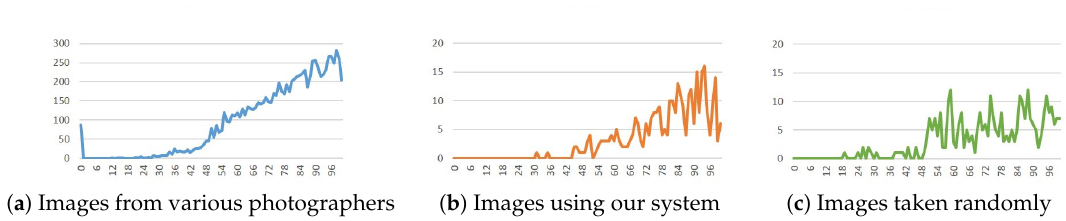
Figure 42. Results for the triangle composition